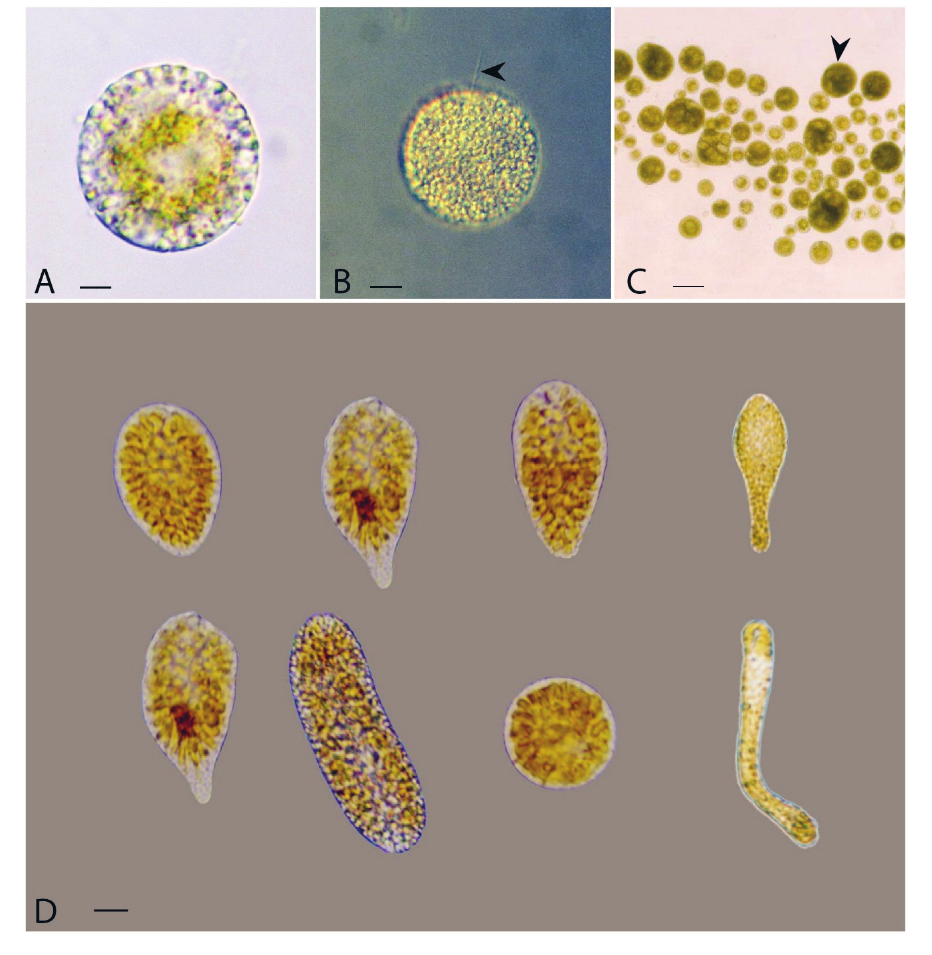
Figure 1. ( A , B ) vegetative cells, one showing a long flagellum (arrowhead) at the anterior end of the Vicicitus globosus cell; and ( C ) a mix of small, gamete-like cells and large multinucleate cells (arrowhead); ( D ) a range of eight different morphotypes of vegetative cells of Chattonella marina observed, from exponential to very late stationary growth